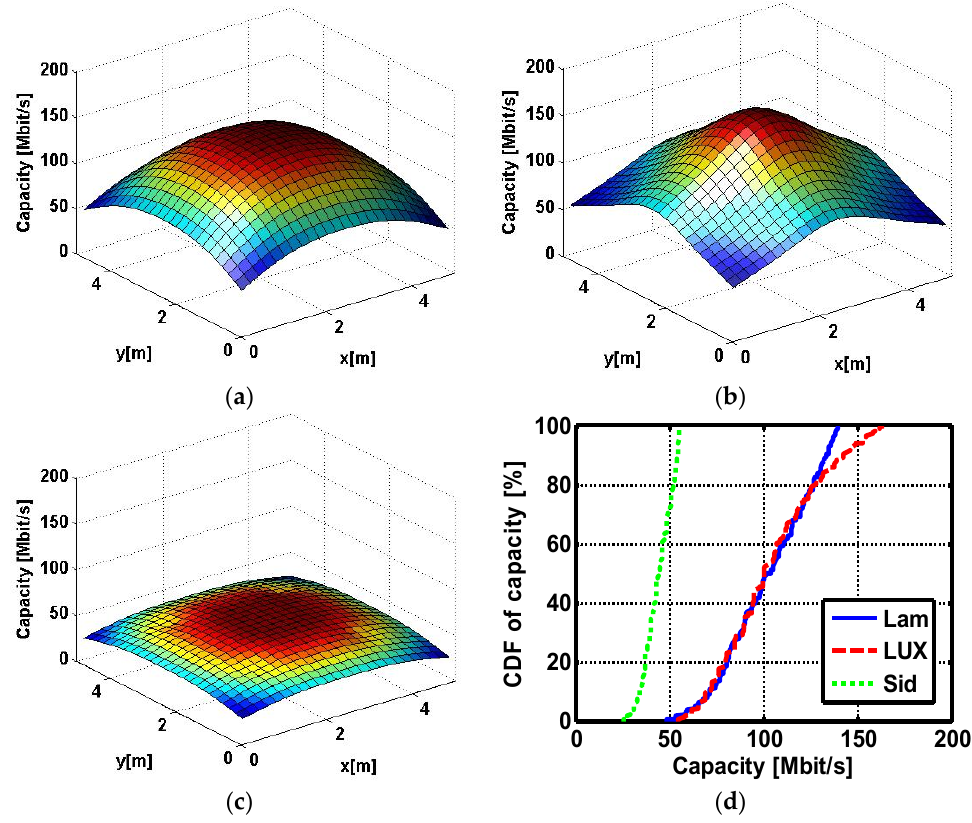
Figure 6. MIMO capacity spatial distribution of ( a ) Lambertian optical beam case; ( b ) LUXEON Rebel optical beam case; and ( c ) Side Emitter optical beam case. ( d ) Cumulative distribution function of the above MIMO capacity.